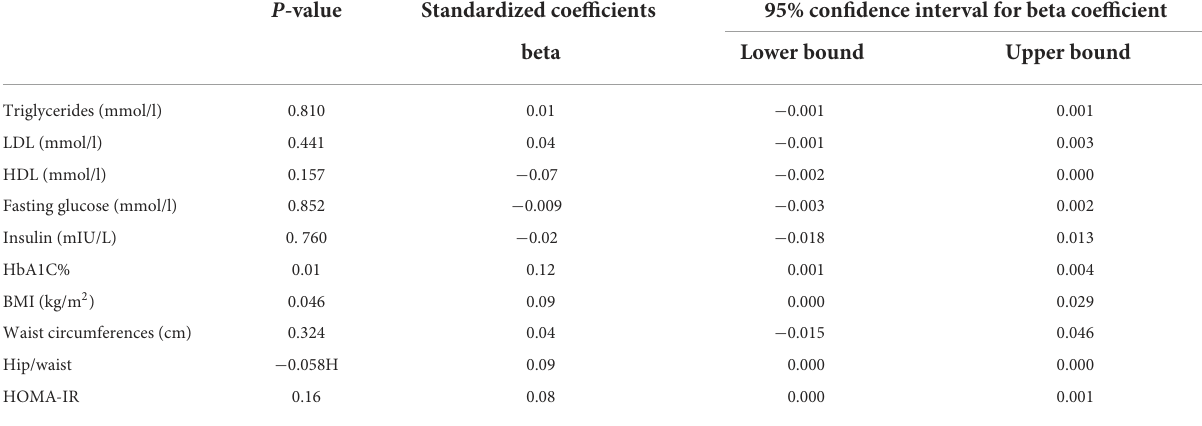
TABLE 5 Regression analysis of afternoon napping (min) with metabolic components after adjustment for age, exercise and night sleep duration. P